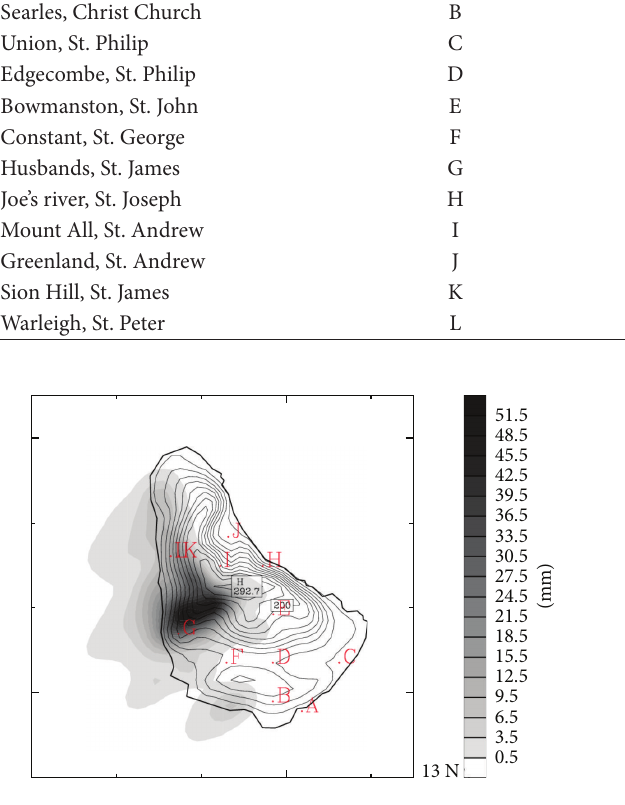
Figure 7: Rainfall accumulations for the 12hr period forecasted from 1200UTC 26 Aug 2008. Letter symbols denote the stations listed in Table